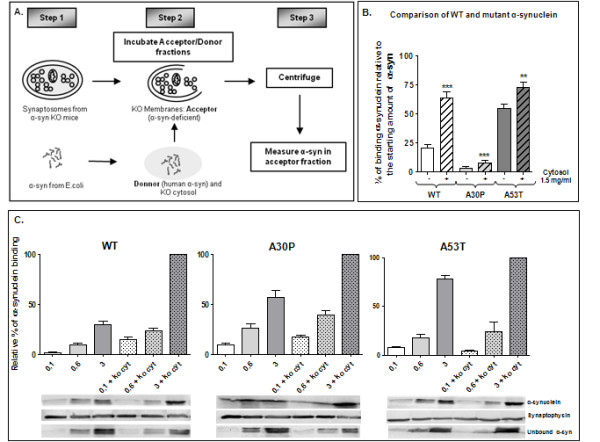
(A) α-syn binding assay. Step 1. Synaptosomes are prepared from α-syn-/- mice and α-syn (human Wt and PD-linked A30P and A53T forms) is expressed and purified from E. coli. Step 2. Synaptic membranes (α-syn acceptor fraction) are prepared from intact synaptosomes using hypotonic buffer and incubated with purified α-syn (donor fraction) in presence or absence of α-syn-/- (KO) cytosol. Step 3. Membrane and cytosol fractions are separated by centrifugation and the membrane proteins are analysed by western blotting. (B) Using the binding assay, KO synaptic membranes were incubated, for 10 min at 37°C, with 3 μg of Wt, A30P or A53T purified α-syn in absence or presence of 1.5 mg/ml of KO cytosol. As shown on this graph, A30P purified α-syn has a lower binding compared to Wt and A53T α-syn in absence (One-Way ANOVA, p < 0.0001, n = 4; Bonferroni's multiple comparison test) or presence (One-Way ANOVA, p < 0.0001, n = 4; Bonferroni's multiple comparison test) of KO cytosol. (C) KO synaptic membranes were incubated, for 10 min at 37°C, with 0.1, 0.6 and 3 μg of Wt, A30P or A53T purified α-syn in absence or presence of 1.5 mg/ml of KO cytosol. Results are normalized to the maximal binding observed for each respective α-syn. These data show that the cytosol has a significant effect by increasing the binding of all types of α-syn (One-Way ANOVA: Wt: p < 0.0001, n = 4; A30P: p < 0.0001, n = 4; A53T p < 0.001, n = 4).